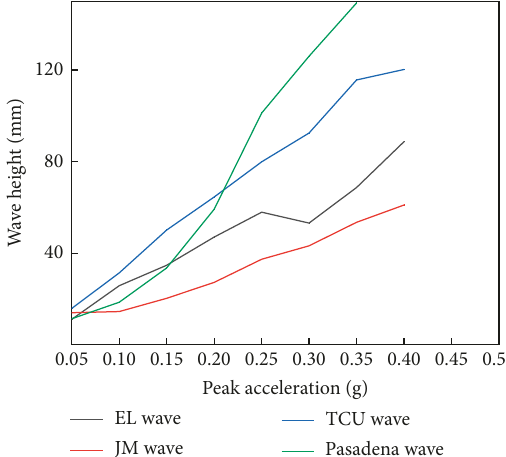
Figure 4: Wave height and peak acceleration trend